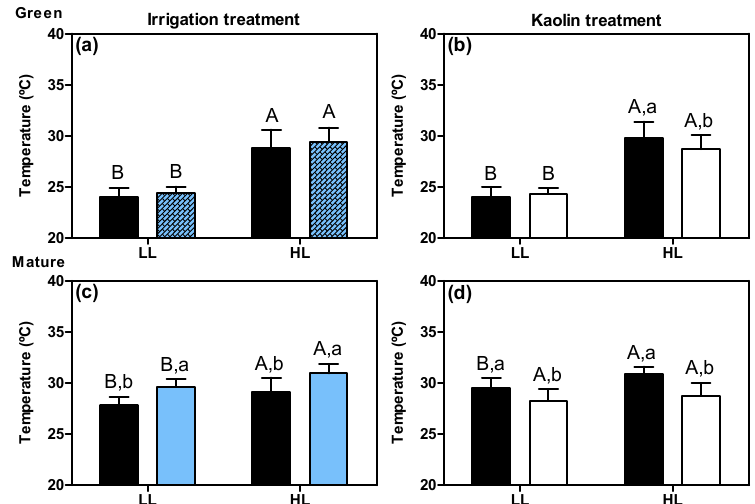
Figure 2. Light intensities received by LL and HL clusters at the green stage ( a , b ) and the mature stage ( c , d ), for plants with irrigation (blue columns, note: the textured blue columns at green stage i.e., before the onset of irrigation, represent the measurements in the plots that were later irrigated) and foliar kaolin application (white columns). Black columns correspond to the respective controls. Values represent means with a standard deviation ( n = 16 plants). Statistical notation: per ripening stage, different capital letters refer to significant differences (two-way ANOVA, p ≤ 0.05) between the two light microclimates within the same plant treatment, and different lowercase letters for differences between treatments within each light microclimate. If the respective factor did not have a significant effect, the lowercase letters were omitted.